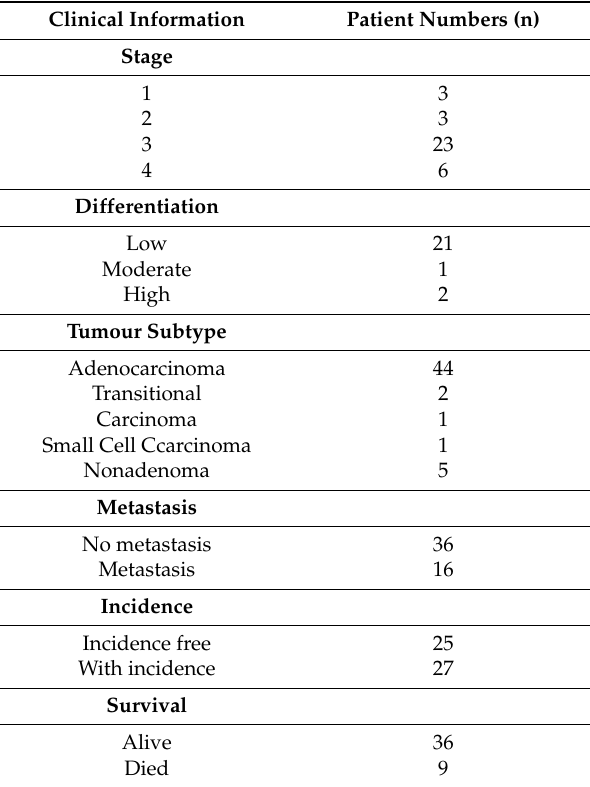
Table 1. Patients’ clinicopathological information.